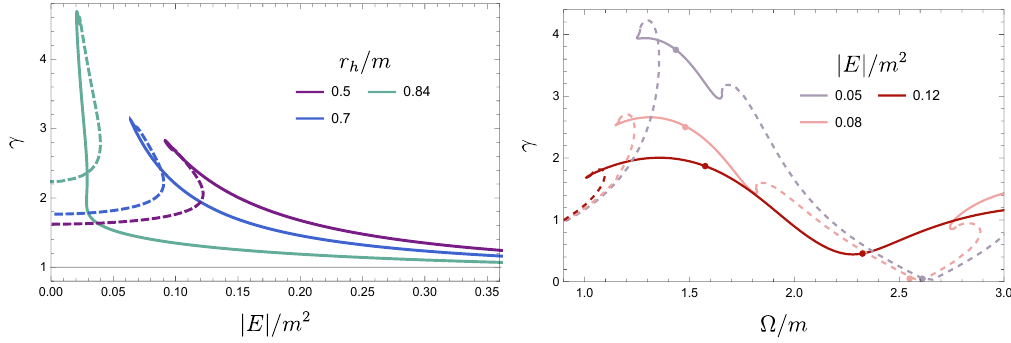
Figure 8 . Modulus of the non-linear conductivity γ = | ˜ σ RC | as a function of | E | /m 2 for fixed Ω /m = 1 . 2 ( left plot ) or as a function of Ω /m for fixed values of | E | /m 2 ( right plot ). For large | E | /m 2 the curves asymptote to the value γ = 1